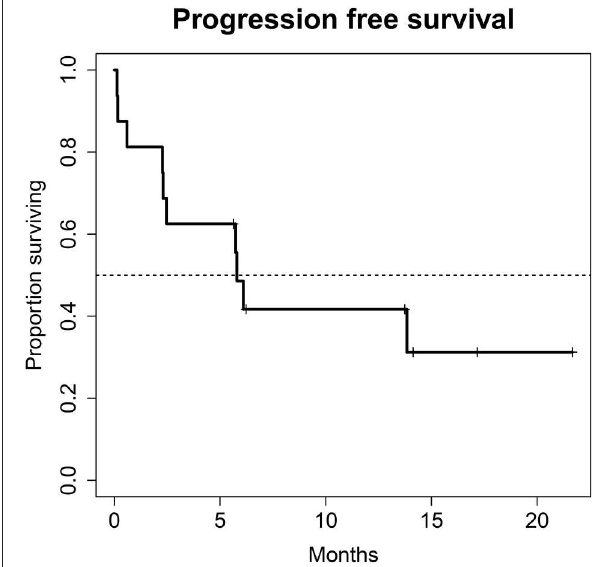
FIGURE 1 | Progression free survival (PFS) for 28 patients under second line therapy with checkpoint inhibitor monotherapy for metastatic urothelial